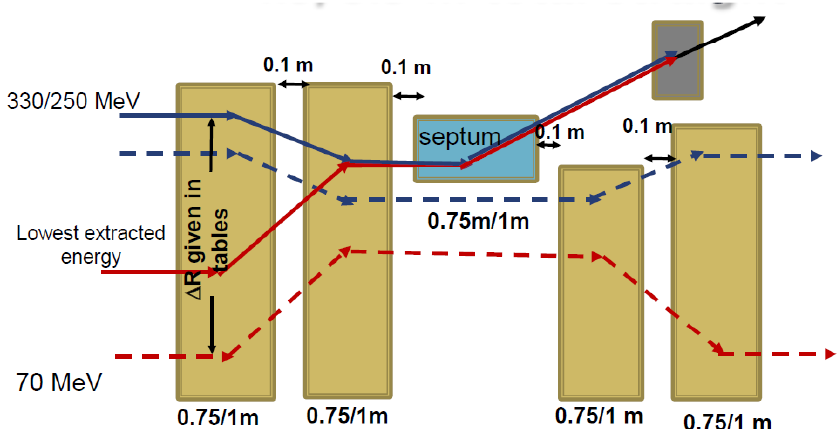
Figure 8. Layout of the ramped, bipolar magnet extraction system that selects the orbit and energy for extraction through a septum. Inner, lower-energy orbits are returned to their respective closed orbits for continued acceleration. Reproduced from Ref. [51].